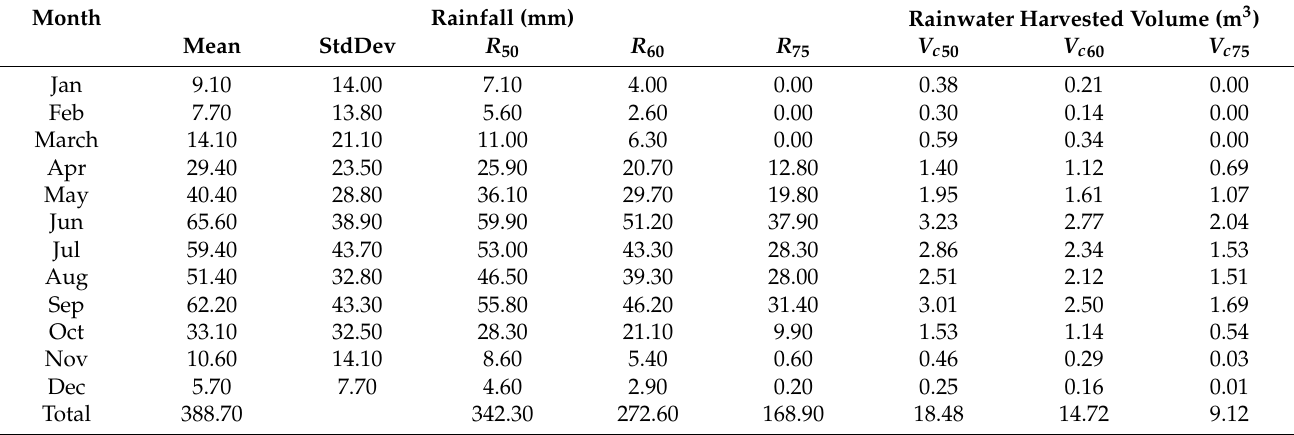
Table 2. Average monthly rainfall with probabilities of occurrence of 50%, 60%, and 75% (mm).